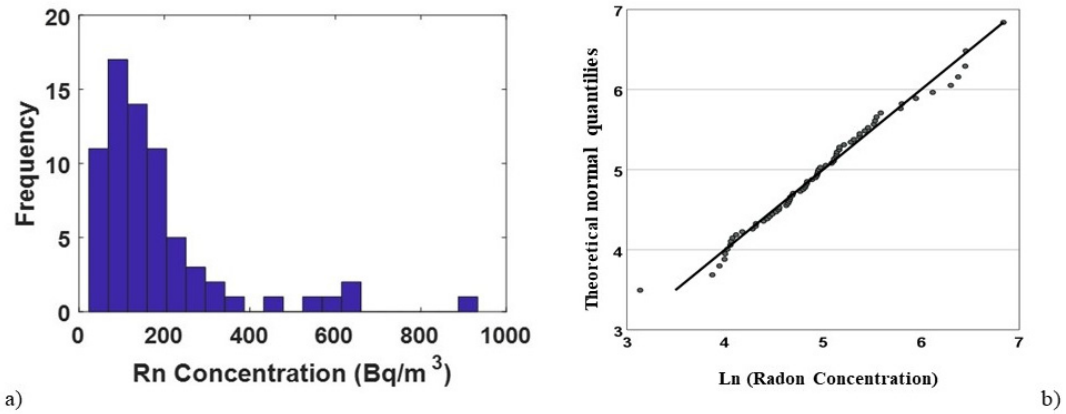
Figure 4. ( a ) Log–normal distribution of the indoor radon concentration for each dwelling; ( b ) Q–norm plot of natural log-transformed radon concentration for each